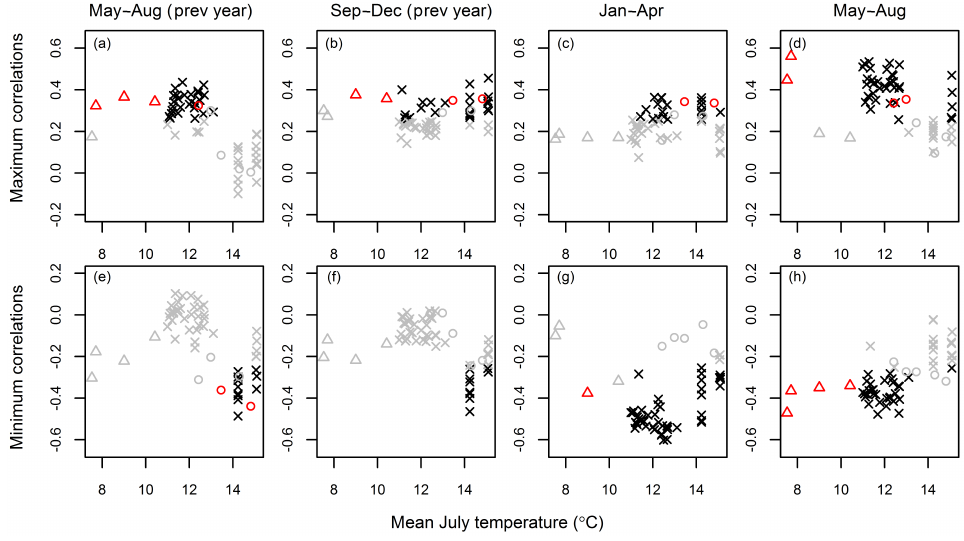
Figure 5. The magnitude of the maximum (largest positive) ( a–d ) and minimum (largest negative) ( e–h ) correlations between the RWIs and temperature against the mean July temperature of each plot. The correlations are shown separately in four seasons, so that the central dates of the time window used for calculating the climate variables is located in the (1) previous growing season (previous year May to August, first column), (2) previous post-growing season (previous year September to December, second column), (3) current pre-growing season (growth year January to April, third column), and (4) current growing season (growth year May to August, fourth column). The black X’s denote the plots in Finland; the red circles and triangles denote the plots of the altitudinal gradients on the south-central Tibetan Plateau (SCTP) and southeastern Tibetan Plateau (SETP), respectively. The grey colour indicates correlations not significant at the 5% level.